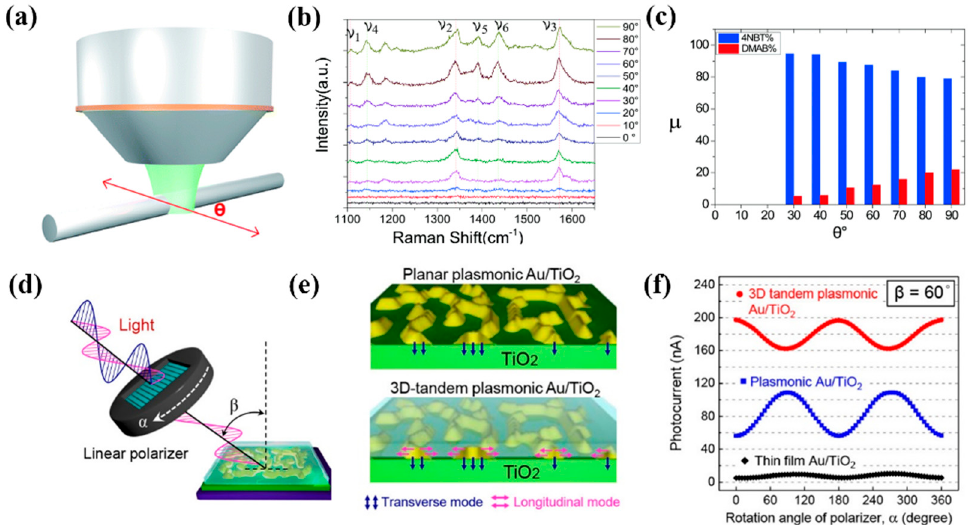
Figure 11. The effect of the polarization of light on metal-semiconductor heterostructures. ( a ) The scheme of light excited on a single Ag nanowire under a microscope. ( b ) The Raman intensity of 4NBT and ( c ) the contents of the converted DMAB under different angles of the incident light. ( a – c ) Reproduced with permission. [108] Copyright 2018, the Royal Society of Chemistry. ( d ) The scheme of the tunable polarization of light and ( e ) the transportation of HCs under both longitudinal and transverse modes. ( f ) The response of the photocurrent in the thin film Au / TiO 2 , 2D Au / TiO 2 and 3D tandem Au / TiO 2 by rotating the angles from 0 to 360 ◦ C. ( d – f ) Reproduced with permission. [109] Copyright 2018, American Chemical Society.